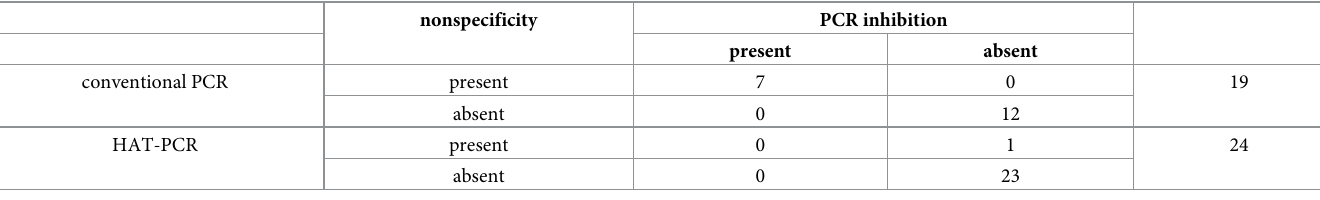
Table 1. Frequency of nonspecificity and PCR inhibition produced by conventional PCR and HAT-PCR. nonspecificity PCR inhibition present absent conventional PCR present 7 0 19 absent 0 12 HAT-PCR present 0 1 24 absent 0 23 Results were from a total of 43